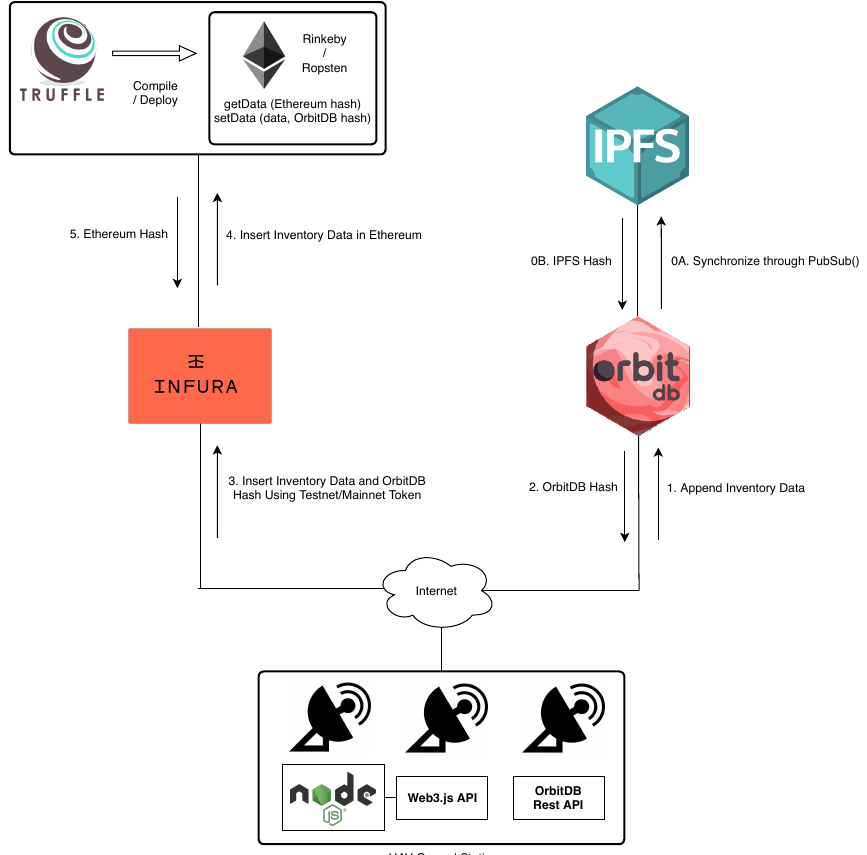
Figure 5. Inventory data insertion process and implemented